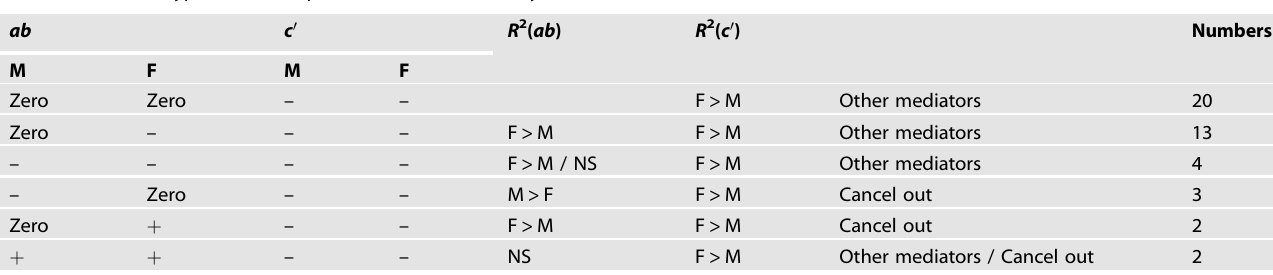
Fig. 3 Sex differences in the effects of psychiatric disorder PRSs on the brain. The IDPs (imaging-derived phenotypes) that was signi fi cantly associated with psychiatric disorders PRSs and the association was different between sexes, referred to as sex-speci fi c IDPs. A The x -axis shows the number of sex-speci fi c IDPs, indicating the psychiatric disorders and the corresponding sex of stronger association (e.g., UKB_SCZ_m represents the genetic association between SCZ PRSs and brain is signi fi cantly stronger in males than females in the UKB). Different colors represent different brain imaging modalities. Orange bins and instance counts from the histogram indicate the sex-speci fi c rsfMRI IDPs. Purple indicates the sex-speci fi c DTI IDPs. Green indicates the sex-speci fi c sMRI IDPs. B The sex-speci fi c brain volume that more associated in females. C , D The sex-speci fi c white matter tracts, D blue indicates the sex-speci fi c white matter tracts of males. scz schizophrenia. Table 3. Different types of effects present in mediation